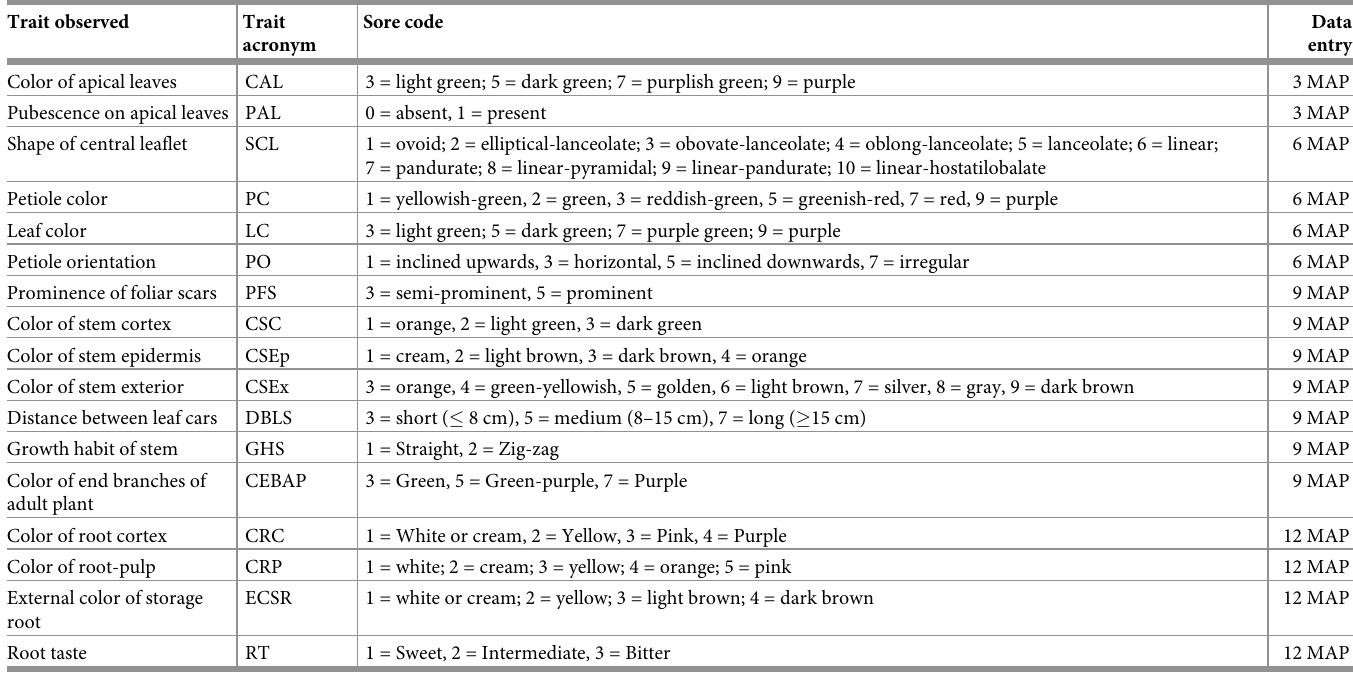
Table 3. Qualitative traits used to characterize 118 cassava genotypes.